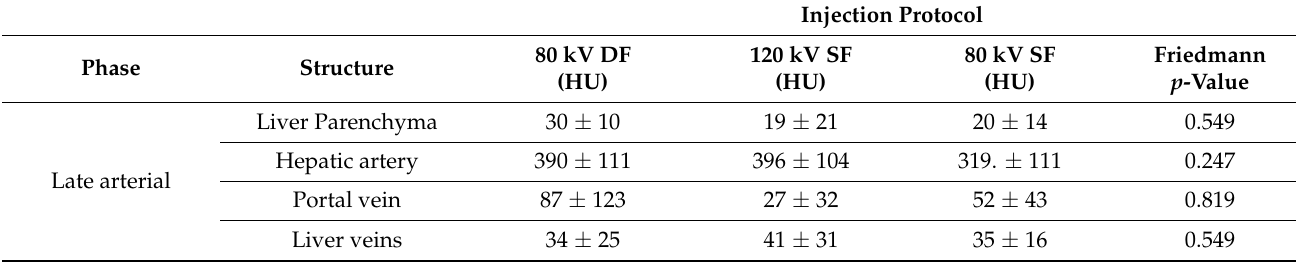
Table 3. Hepatic peak